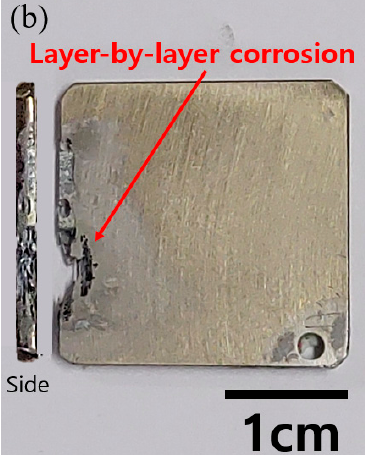
Figure 5. ( a ) Determination of E ‐ CLCP values for the as ‐ received AM Ti–6Al–4V alloy at 37 °C in Ringer solution (note that the small arrow indicates the direction of current flow); ( b ) the shape of the layer ‐ by ‐ layer corroded area of the as ‐ received AM Ti–6Al–4V alloy. Inset is the magnified area around E ‐ CLCP for the corresponding graph. (PODY: potentiodynamic; GAST: galvanostatic; POST: potentiostatic polarization).